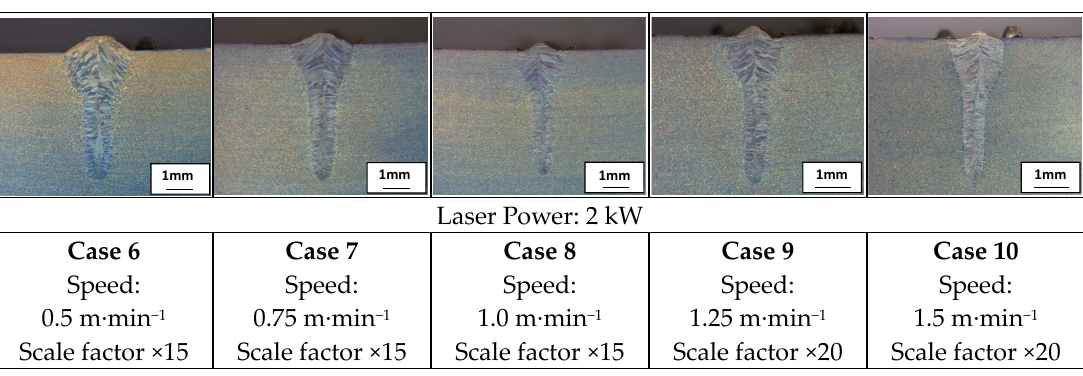
Figure 4. Bead geometry on BOP welding test (laser power: 2 kW, Case 6~10).